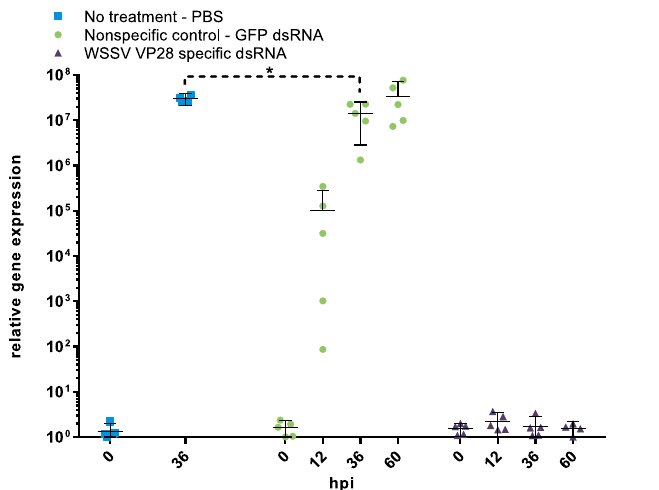
Figure 5. A VP28 mRNA specific RT-qPCR assay, without specificity for the VP28 dsRNA treatment, was applied in order to monitor WSSV replication rate during the first 60 hours of infection. The relative gene expression measured at 0 hpi arise from variation in reference gene expression and not VP28 mRNA, for which all samples collected at 0 hpi did not produce any Cq-values. Similarly, no Cq-values were obtained at 12, 36 and 60 hpi for the VP28 dsRNA treatment group. One-way ANOVA with Bonferroni’s multiple comparisons test was performed on GFP dsRNA treatment at 36 hpi in comparison to no treatment (PBS) at 36 hpi, showing significant variation at α = 0.05. Error bars indicate the 95% CI around the